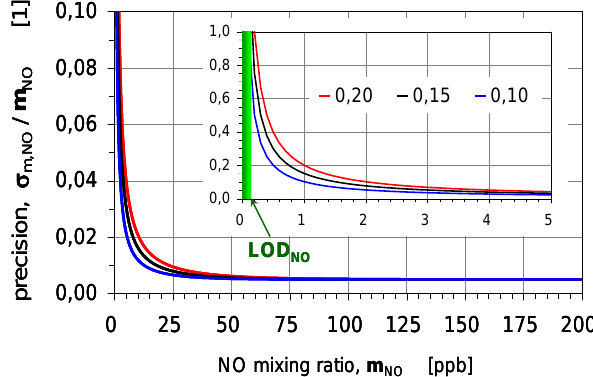
Figure 8. Precision of NO mixing ratios measured by the used NO x Fig. 7: Precision of NO mixing ratios measured by the used NO x -analyzer. Data have analyser. Data have been obtained (a) during routine multipoint cal- been obtained (a) during routine multipoint calibration exercises, and (b) during ibration exercises, and (b) during each drying-out experiment us- each drying-out experiment using different m NO,in . Note LOD NO and the sharp of ing different m NO , in . Note LOD NO and the sharp of precision for precision for m NO < 10 ppb as shown in the insert of Fig. 7. m NO <10ppb as shown in the insert of Fig. 7.